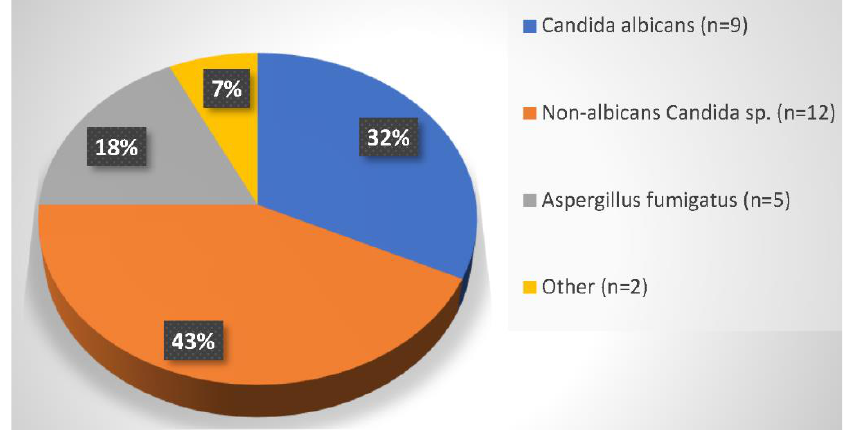
Figure 3. Composition of pathogens.